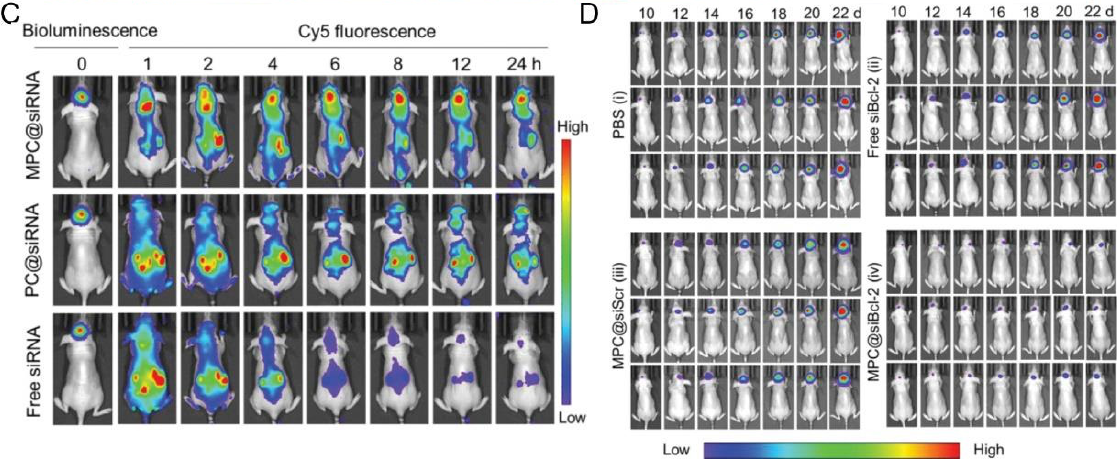
Figure 11. ( A ) Schematic illustration of the PC@siRNA nanocomplexs coated with B16F10 cell membranes for the combination of chemodynamic therapy (CDT) and RNAi in orthotopic glioblastoma. ( B ) Schematic diagram of nanocomplex-mediated BBB penetration. ( C ) In vivo imaging of Cy5-labeled MPC@siRNA in orthotopic U87MG-Luc GBM tumor model. ( D ) In vivo anti-GBM performance of MPC@siBcl-2. CS 2 , carbon disulfide; PEX, polyethyleneimine xanthate; Bcl-2, B-cell lym- phoma 2; PLL-CA, citraconic anhydride grafted poly-lysine; GBM, glioblastoma; GSH, glutathione; GSSG, glutathione disulfide; ROS, reactive oxygen species. Reprinted with permission from Ref. [137], © 2022 The Authors. Advanced Functional Materials published by Wiley-VCH GmbH.